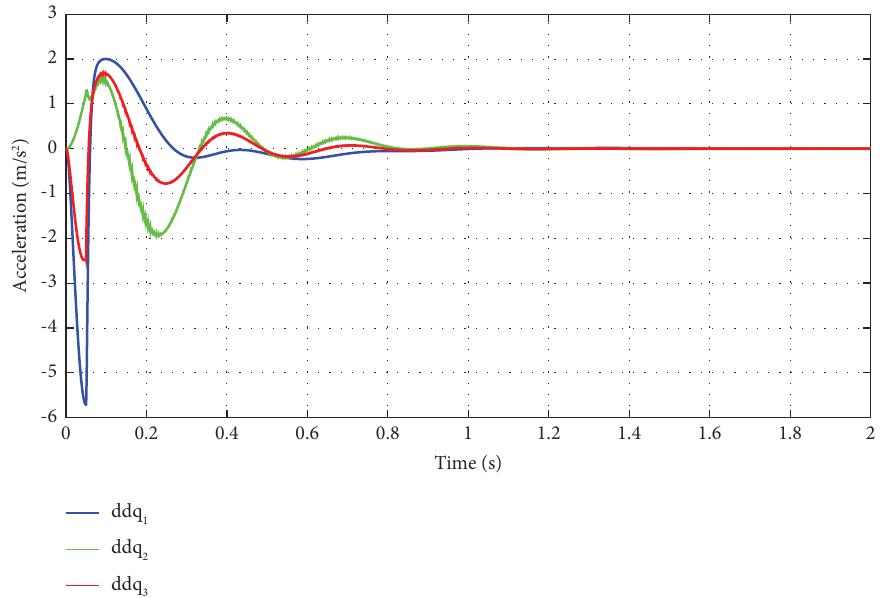
Figure 8: Accelerations of parts of the mobile antiaircraft weapon system after launch: ddq truck, ddq 2 -vertical acceleration of rear suspension of the truck, and ddq 3 -vertical acceleration of the center of mass of the truck.